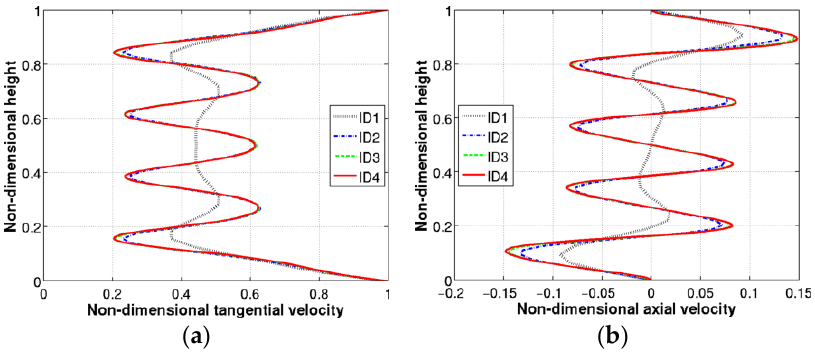
Figure 4. Non-dimensional velocity components along a vertical line in the middle of the gap between fiber and vial for the four grids tested: ( a ) Tangential velocity; ( b ) Axial velocity.